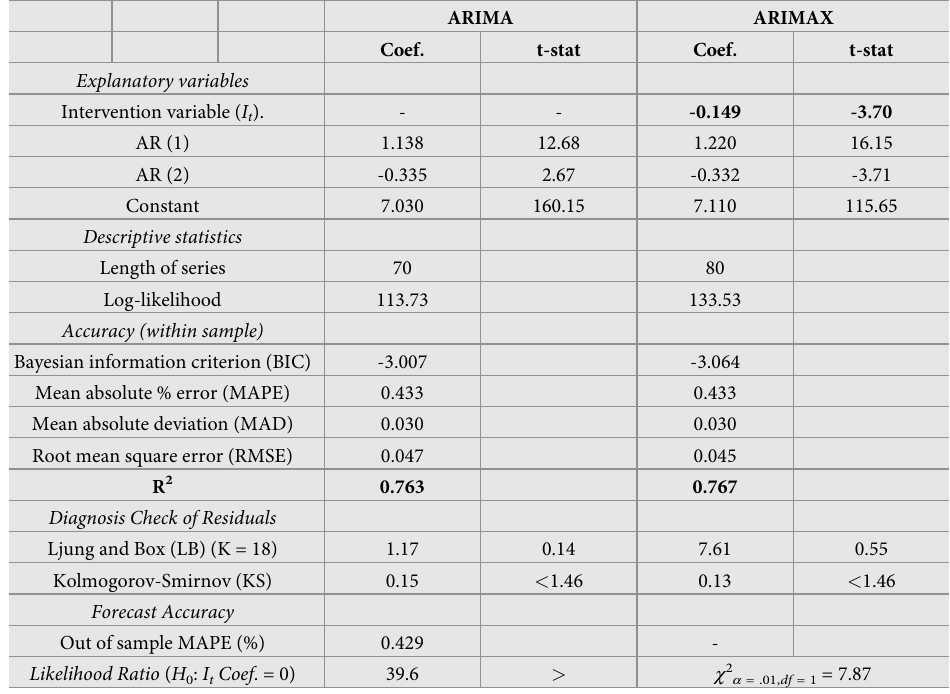
Table 2. Intercity traffic flow prediction model for log transformed